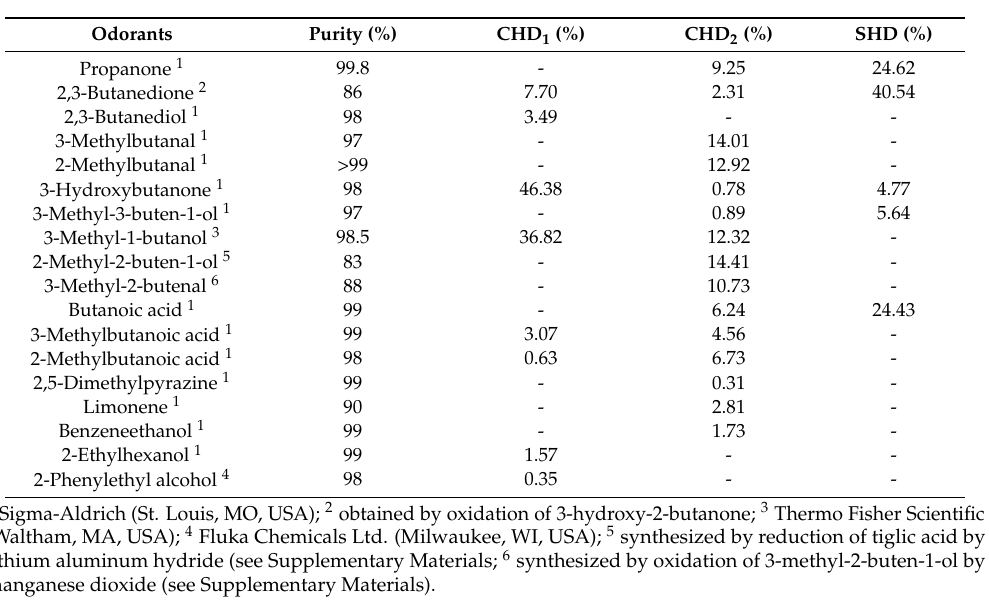
Table 2. Blends of synthetic honeydew odorants prepared according to compositions of crude honeydew collected in this study (CHD 1 ), and in a previous study (CHD 2 ) [32], and of sterilized honeydew (SHD) reported in the previous study [32].